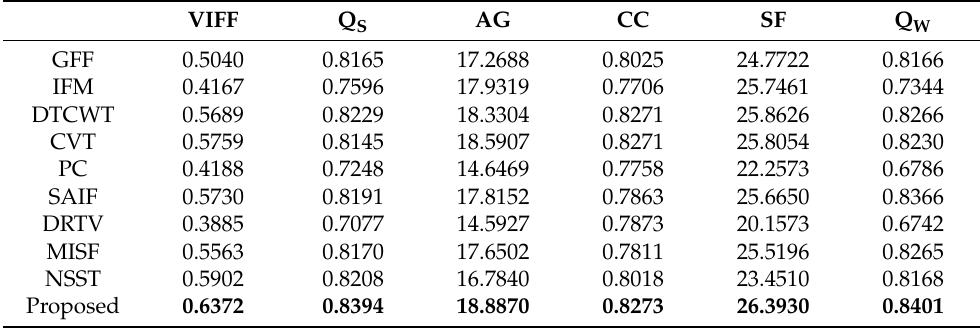
Table 5. The average objective evaluation of the methods on the sixteen group